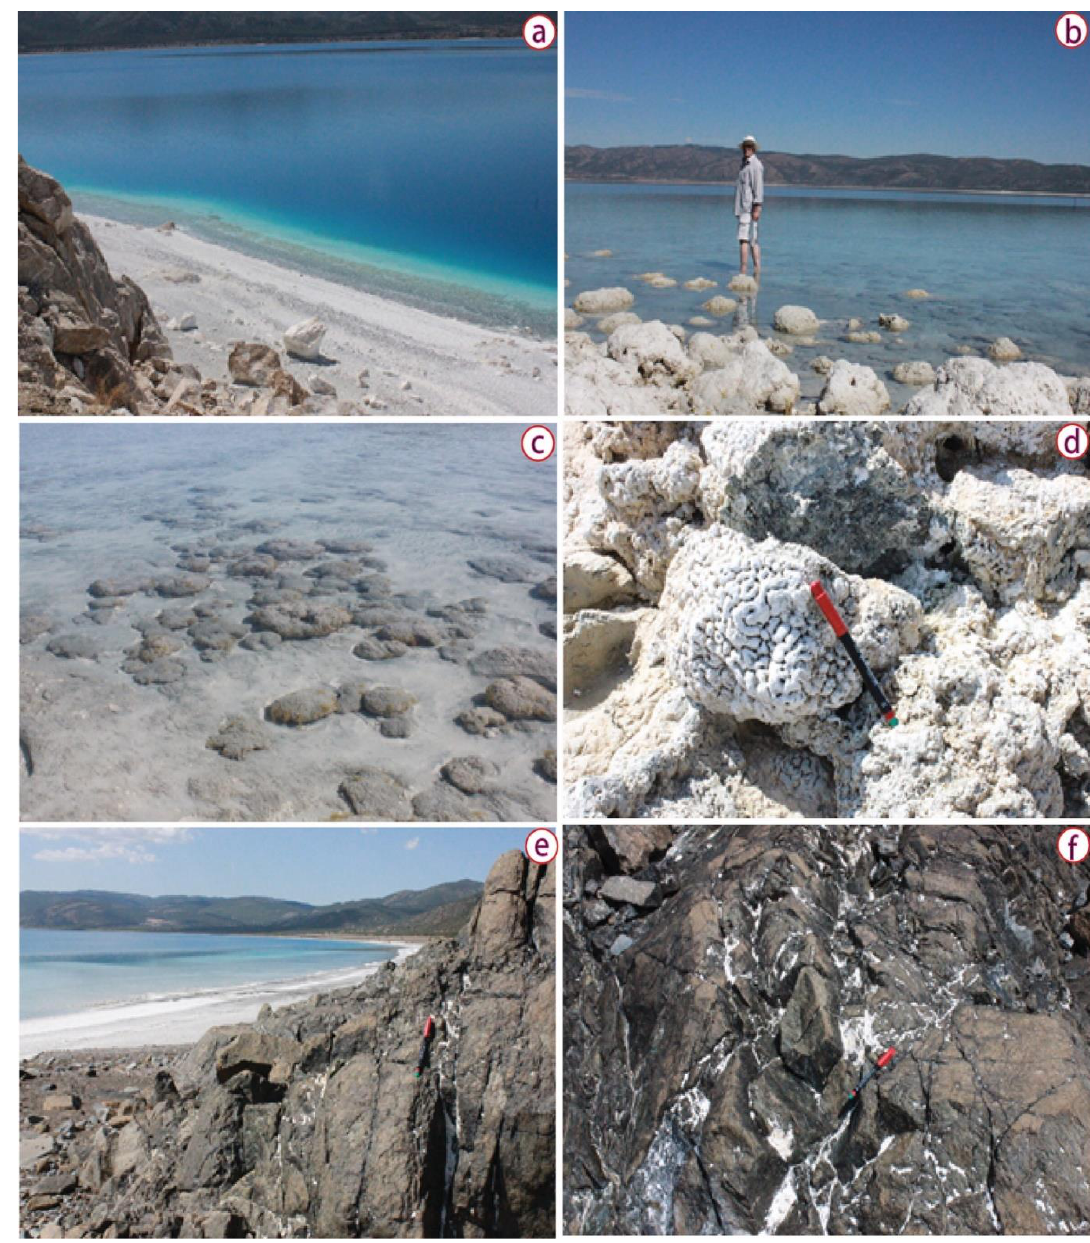
Figure 2. ( a ) General view from Lake Salda, ( b , c ) stromatolite, ( d ) fosil stromatolite, ( e , f ) Serpentin- ized ultrabasic rock near Lake Salda and hydromagnesite in its